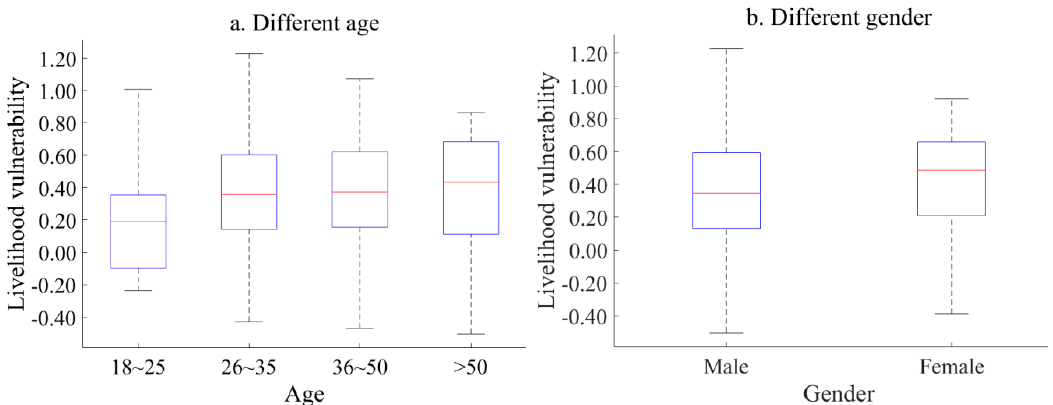
Figure 3. Livelihood vulnerability index for employees of different ages and genders.